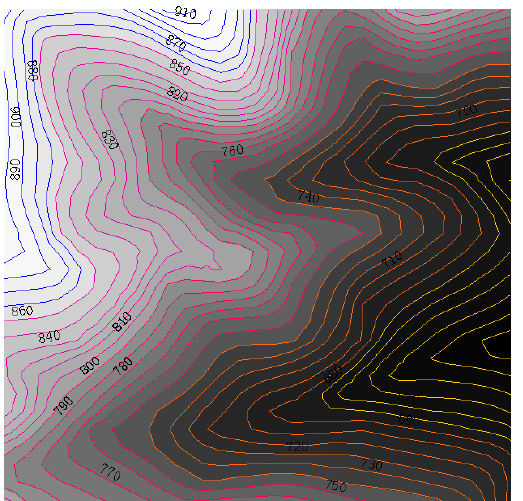
(b) The lower plateau image superimposed by the contour lines